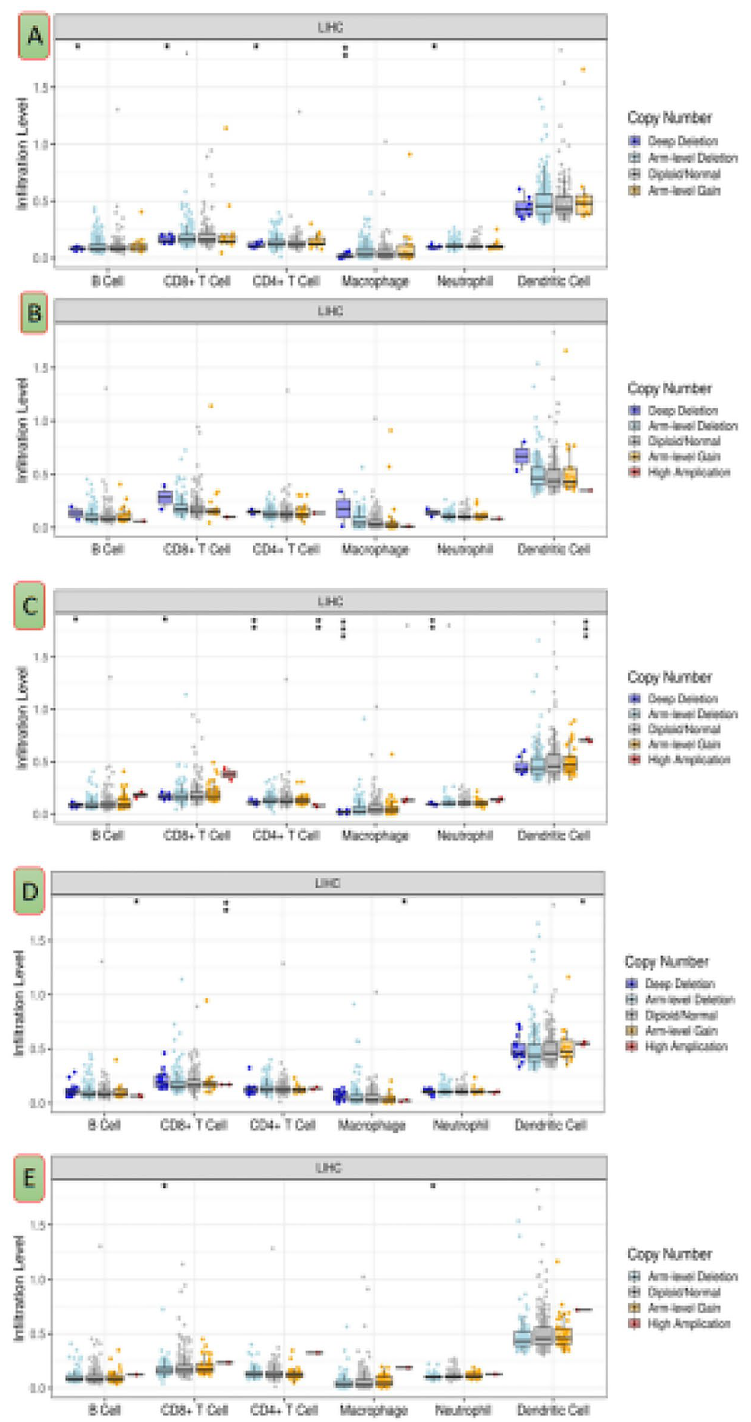
Figure 8. Hub gene expression analysis in different immune cells (http:// timer. cistr ome.